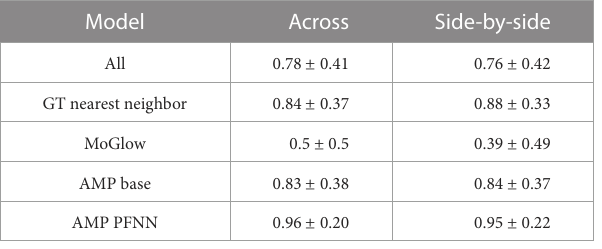
TABLE1 Referentialaccuracyresults(meanandstandarddeviation)for “across”and“side-by-side”agentpositionsinVRperceptualevaluation.